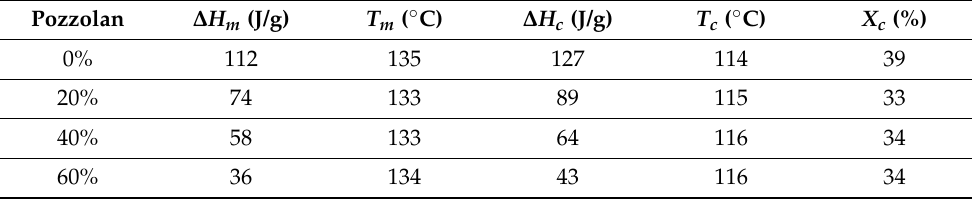
Table 4. Thermal properties obtained by differential scanning calorimetric